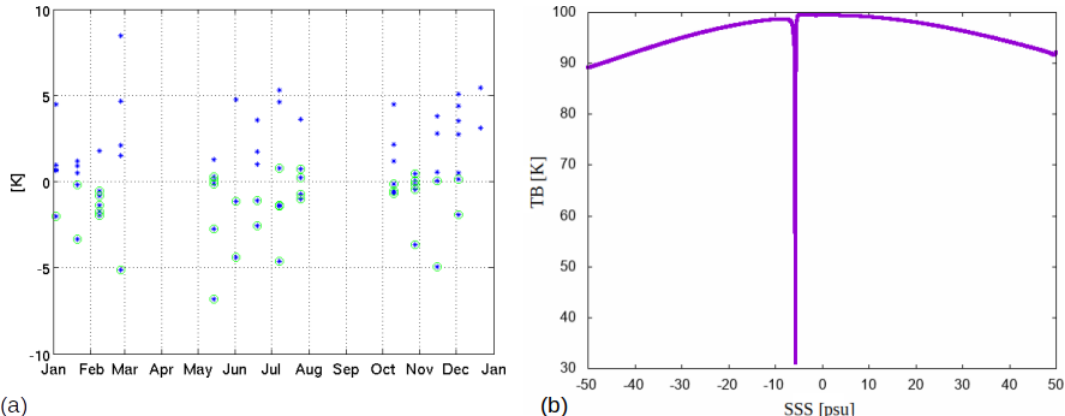
Figure 3. (a) Difference of SMOS and modeled TB (blue stars) for ascending orbits in 2013 for the following acquisition conditions: ( ϕ = 56 ◦ , λ = 19 ◦ , ascending ,x = 0km, θ = 42 . 5 ◦ ). Green circles indicate those measurements for which a valid SSS is retrieved. (b) Half first Stokes modeled TB (M&W model) versus raw SSS for θ = 40 ◦ and T s = 0 ◦ C . Note that negative SSS values do not have any physical meaning. They only reflect the presence of instrumental biases that need to be corrected.